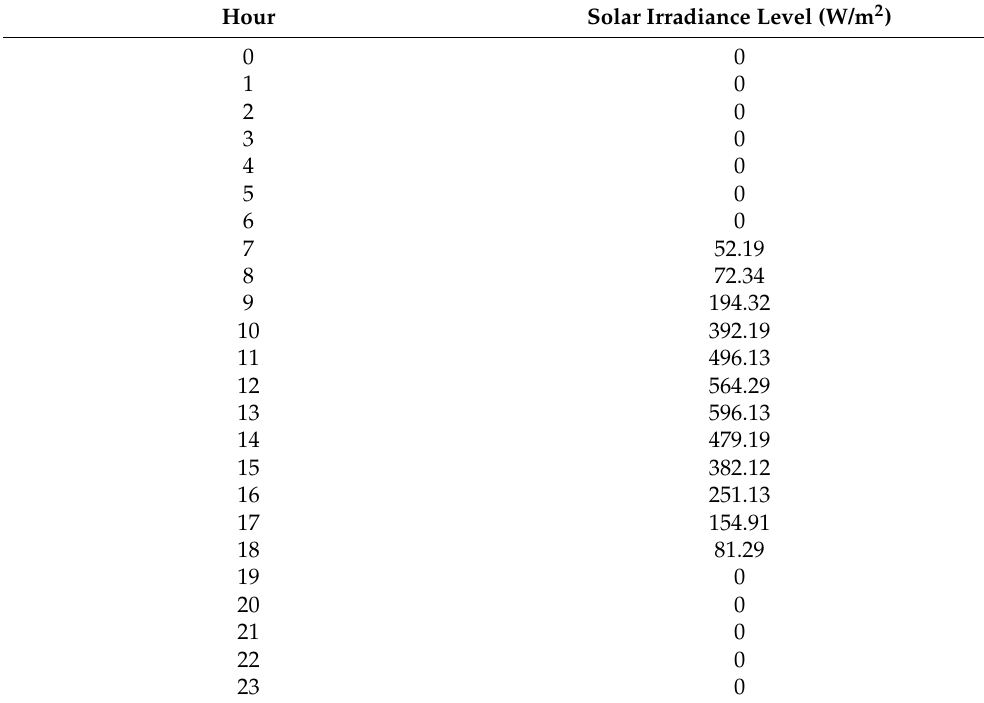
Table 4. Predicted values of the solar irradiance level.